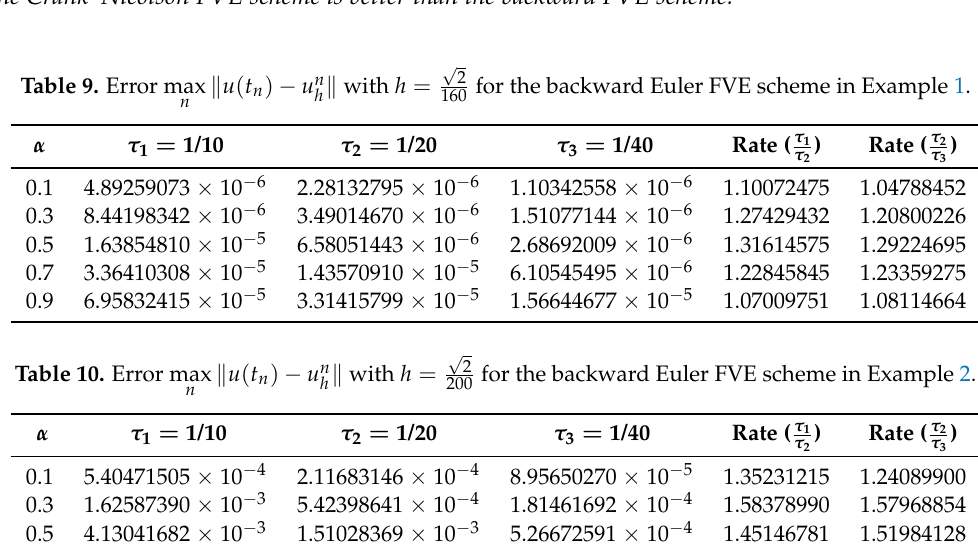
Table 9. Error max